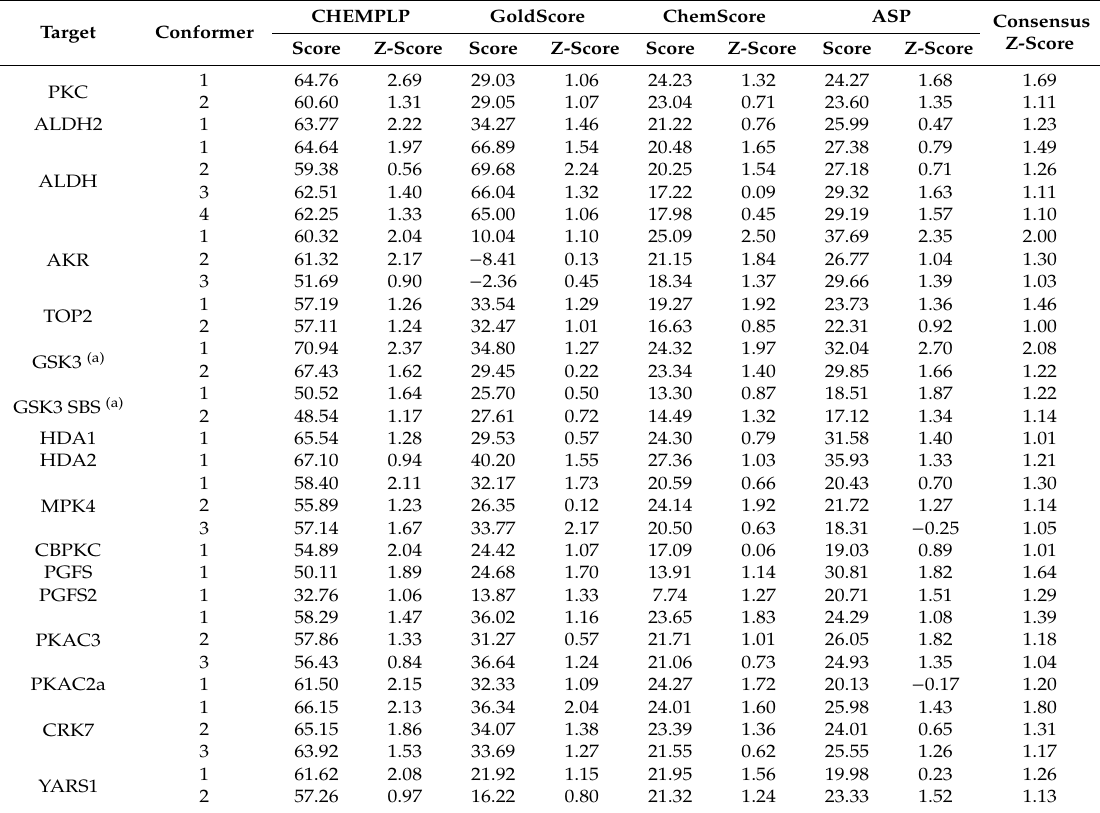
Table 3. Results of the molecular docking of compound 9 to its predicted potential molecular targets in Leishmania braziliensis